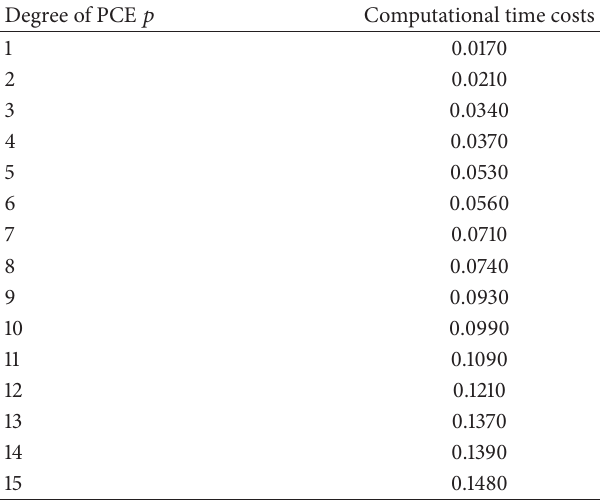
Table 12: Time costs of computations for PCE, approximating GBM at 𝑇 = 1 for 𝑟 = 3 %, 𝜎 = 15 %, and 𝑆 0 = 100